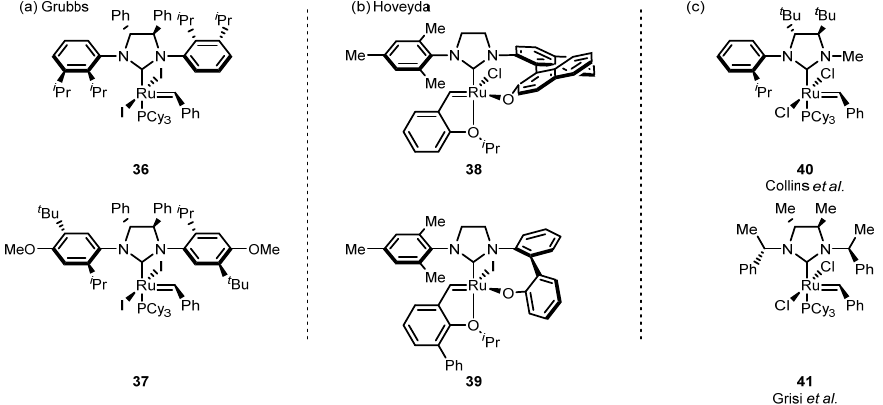
Figure 11. Various catalyst designs used to achieve asymmetric OM. ( a ) C 2 -symmetric NHC ligands employed by Grubbs and coworkers; ( b ) Bidentate NHC ligands employed by Hoveyda and coworkers; ( c ) Geared NHC ligands employed by the Collins and Grisi groups.